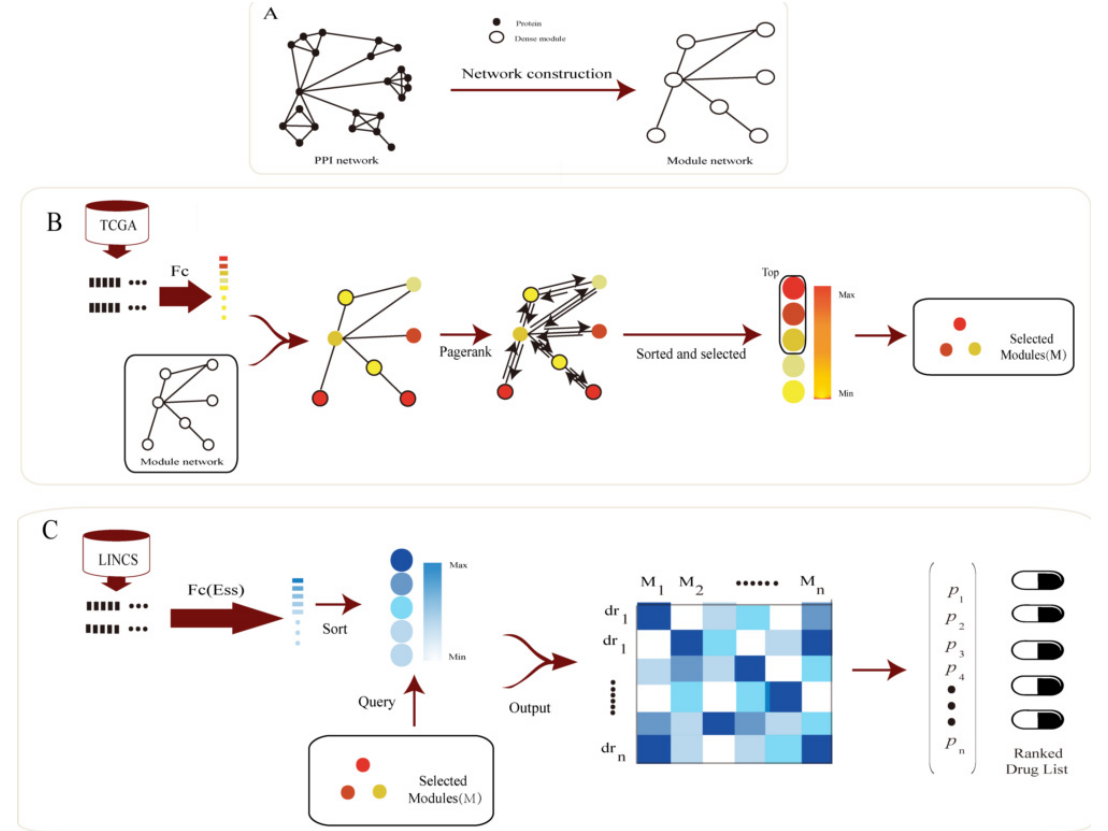
Figure 1. Pipeline of Module Network Based Drug Repositioning (MNBDR). ( A ) MNBDR detects dense modules in the PPI networks and captures the cross-talks among the modules by permutation test to form a module network. ( B ) Based on the module network and gene expression data of disease samples, MNBDR applies the Pagerank algorithm to rank the important modules in disease. ( C ) Using the important modules in disease and the gene expression data of drug stimulating samples, MNBDR applies a new indicator to infer potential associations between drugs and dis- eases.